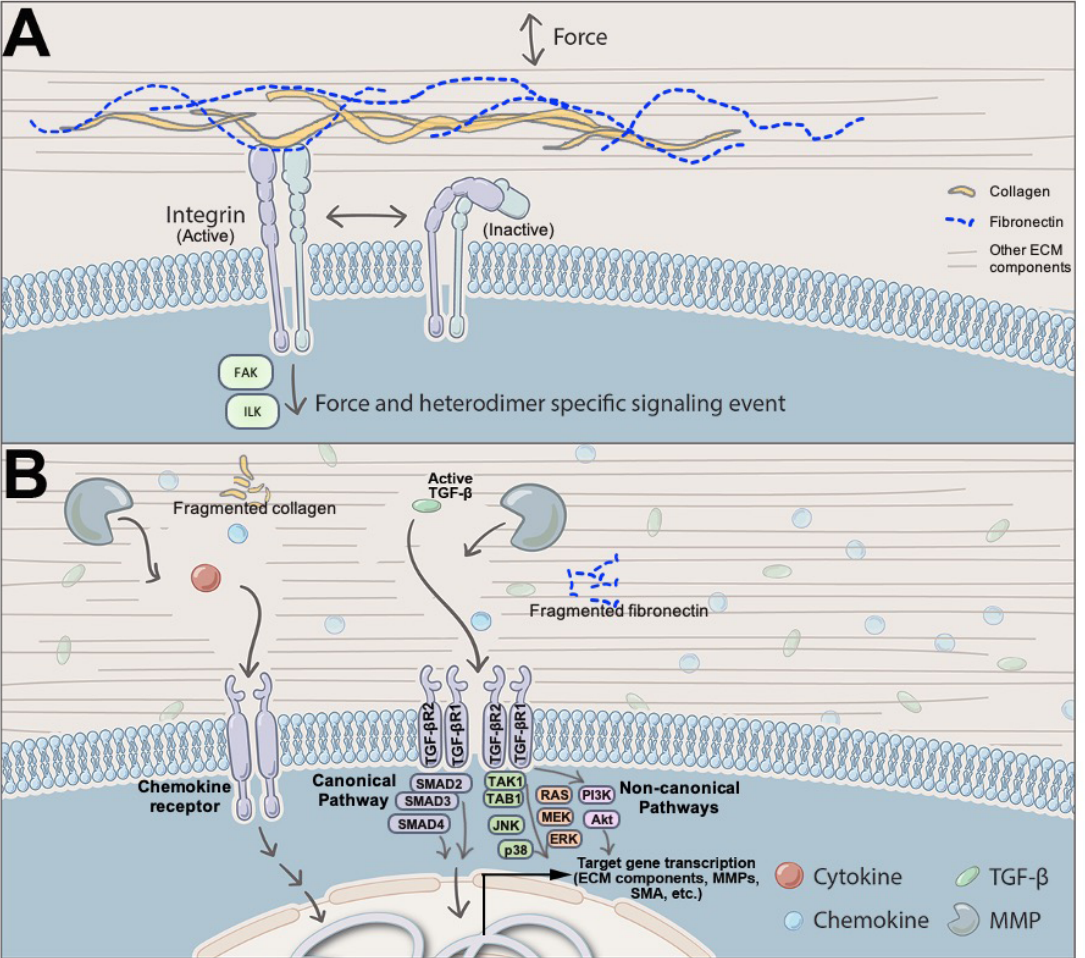
Figure 2. ECM-VIC Signaling Interactions. ( A ) Matricellular and mechanical signaling occurs in a force-, ligand-, and integrin heterodimer-specific manner. Once active, integrin heterodimer complex leads to activation of downstream pathways mediated by activation of signaling molecules, including focal adhesion kinase (FAK) and integrin-linked kinase (ILK). ( B ) During matricrine signaling in heart valves, metalloproteases (MMP) degrade structural components of the ECM, which allow signaling molecules such as cytokines, chemokines, and TGF- β to be released. Once activated by TGF- β , TGF- β receptors result in transcription of pro-fibrotic and pro-inflammatory genes via canonical or non-canonical TGF- β signaling cascade in VICs.